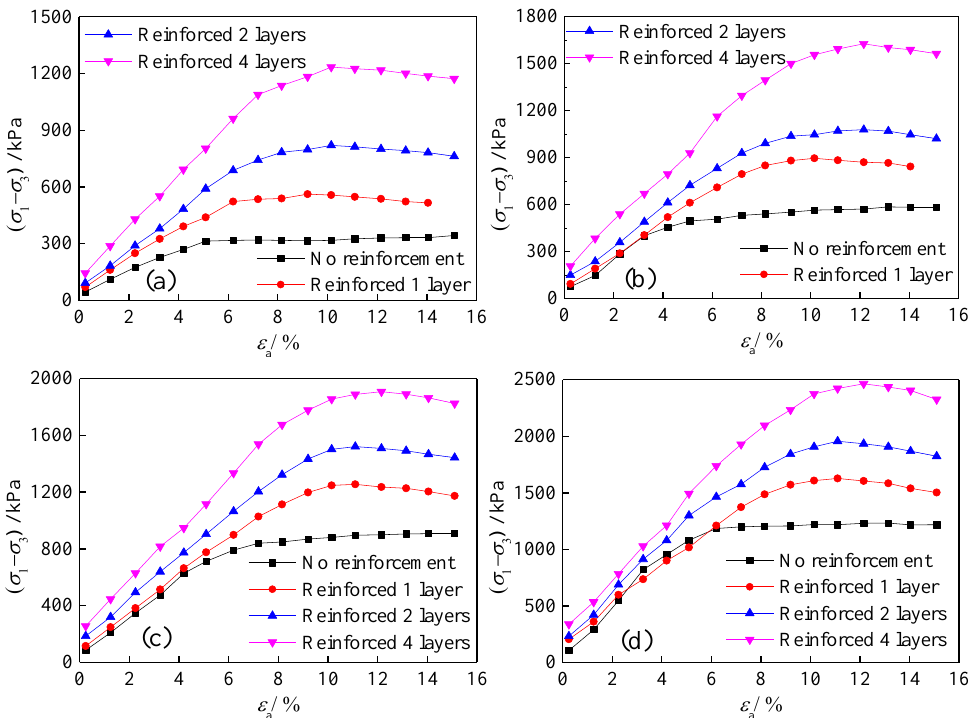
Figure 5. Stress–strain curves of reinforced tailings under different reinforced layers of geotextiles: ( a ) Confining pressure 100 kPa, ( b ) confining pressure 200 kPa, ( c ) confining pressure 300 kPa, and ( d ) confining pressure 400 kPa.